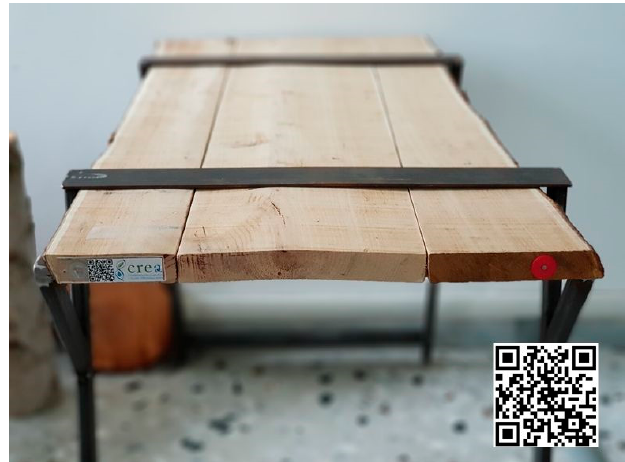
Figure 8. Table made with marked chestnut boards. It is possible to observe the RFID devices (red on the right), QR code (on the left of the word CREA and on the right of the image) and NFC (on the left of the QR code). The QR code shows the web page that the consumer can consult to view the information related to the boards with which the table was made.